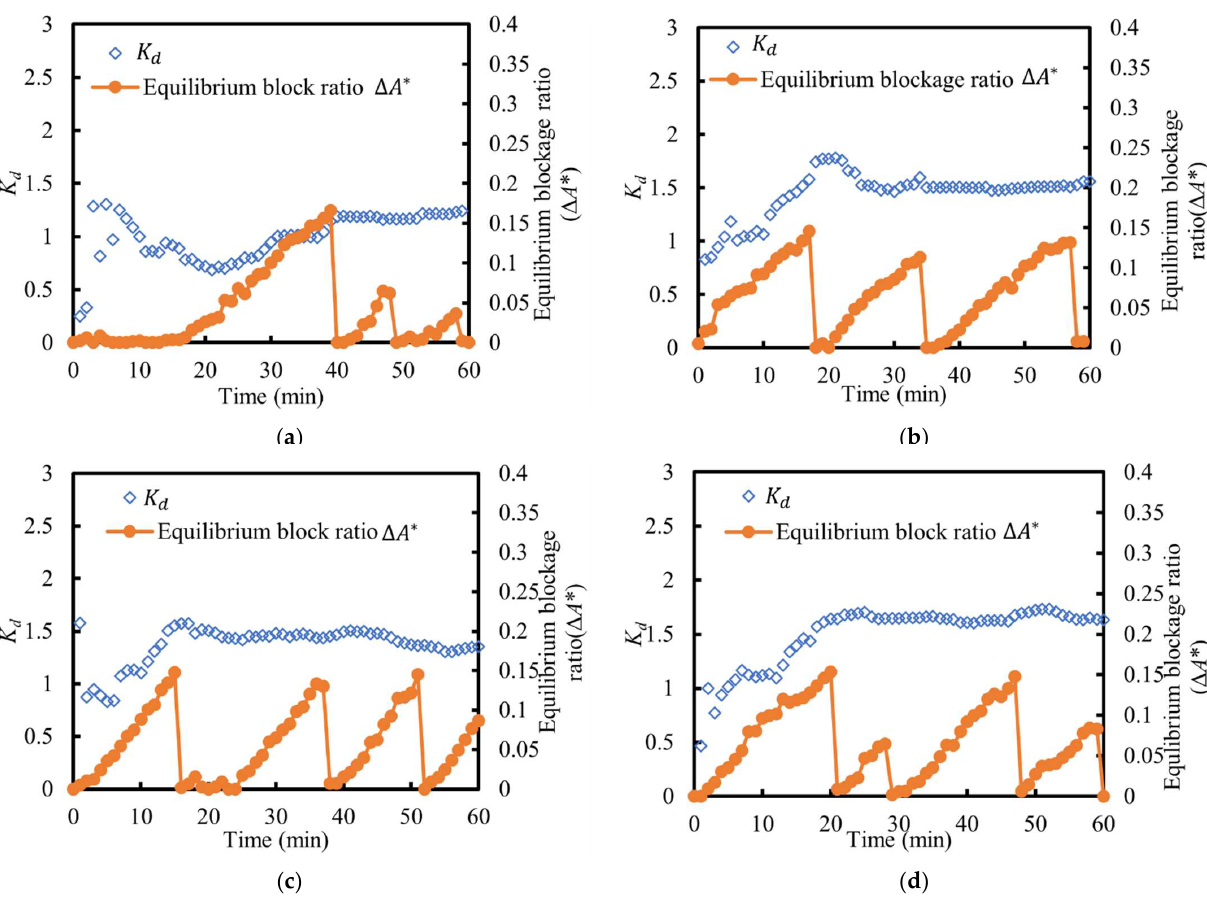
Figure 11. Time-history of the evolution of the relative scour depth K d and equilibrium blockage ratio ∆𝐴 ∗ ( a ) test 1; ( b ) test 2; ( c ) test 3; ( d ) test 4.